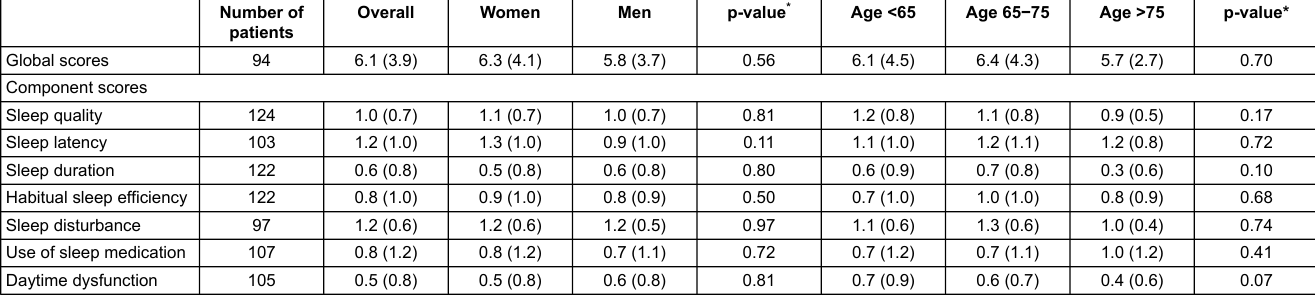
Table 2: Pittsburgh Sleep Quality Index (PSQI) global and component scores (means and standard deviations), overall and stratified by gender and age group. Number of patients